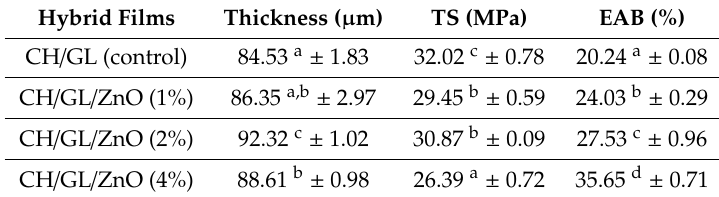
Table 1. Thickness and mechanical properties of the hybrid nanocomposite